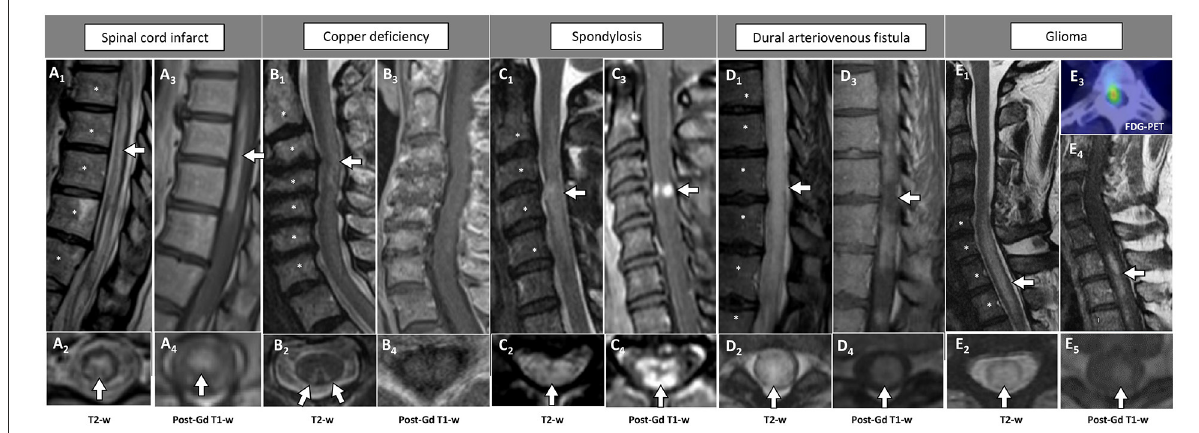
FIGURE2 Examples of longitudinally extensive spinal cord lesions mimicking inflammatory myelopathies on MRI. The extension of the T2-hyperintensities along consecutive vertebral segments is highlighted by asterisks. [ (A) Spinal cord infarct] Thoracic T2-hyperintense spinal cord lesion [ (A 1 ) arrow] mainly involving the gray matter [ (A 2 ) arrow], with corresponding anterior linear enhancement on sagittal view (A 3 ) and homogeneous enhancement on axial view (A 4 ) . [ (B) Copper deficiency] Cervical T2-hyperintense spinal cord lesion [ (B 1 ) arrow] selectively involving the dorsal columns bilaterally in a rabbit ears configuration [ (B 2 ) arrows], not showing concomitant contrast-enhancement (B 3 ,B 4 ) . [ (C) Spondylosis] Cervical T2-hyperintense spinal cord lesion located right under the level of maximal spinal cord compression [ (C 1 ) arrow], diffusively involving the cross-sectional area of the cord [ (C 2 ) arrow], showing a transverse area of contrast-enhancement on sagittal view [“pancake sign”, (C 3 ) arrow], corresponding to a peripheral area of contrast enhancement on axial images [ (C 4 ) arrow]. [ (D) Dural arteriovenous fistula] Thoracic T2-hyperintense spinal cord lesion [ (D 1 ) arrow], diffusively involving the cross-sectional area of the cord [ (D 2 ) arrow], showing a focal lack of enhancement in an otherwise homogeneous pattern of contrast enhancement on sagittal images [“missing-piece sign”, (D 3 ) arrow], and homogeneous enhancement on axial images [ (D 4 ) arrow]. [ (E) Glioma] Cervico-thoracic T2-hyperintense spinal cord lesion [ (E 1 ) arrow], diffusively involving the cross-sectional area of the cord [ (E 2 ) arrow], showing homogeneous contrast enhancement on both sagittal [ (E 4 ) arrow], and axial images [ (E 5 ) arrow]. Increased glucose uptake is also observed, corresponding to an area of red signal in the positron-emission tomography (E 3 ) . FDG-PET, 18 F-Fluorodeoxyglucose-positron emission tomography; Gd, gadolinium; T2-w, T2-weighted; T1-w,